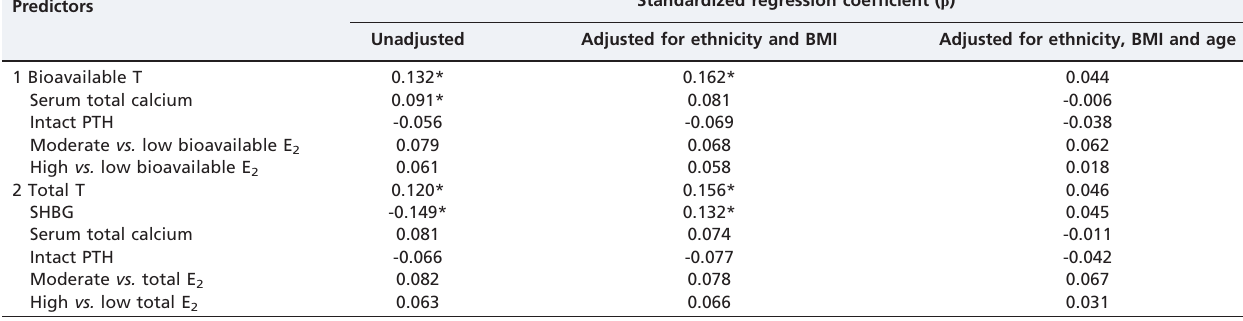
Table 2 - Results of a stepwise multiple regression between calcaneal speed of sound values and biochemical